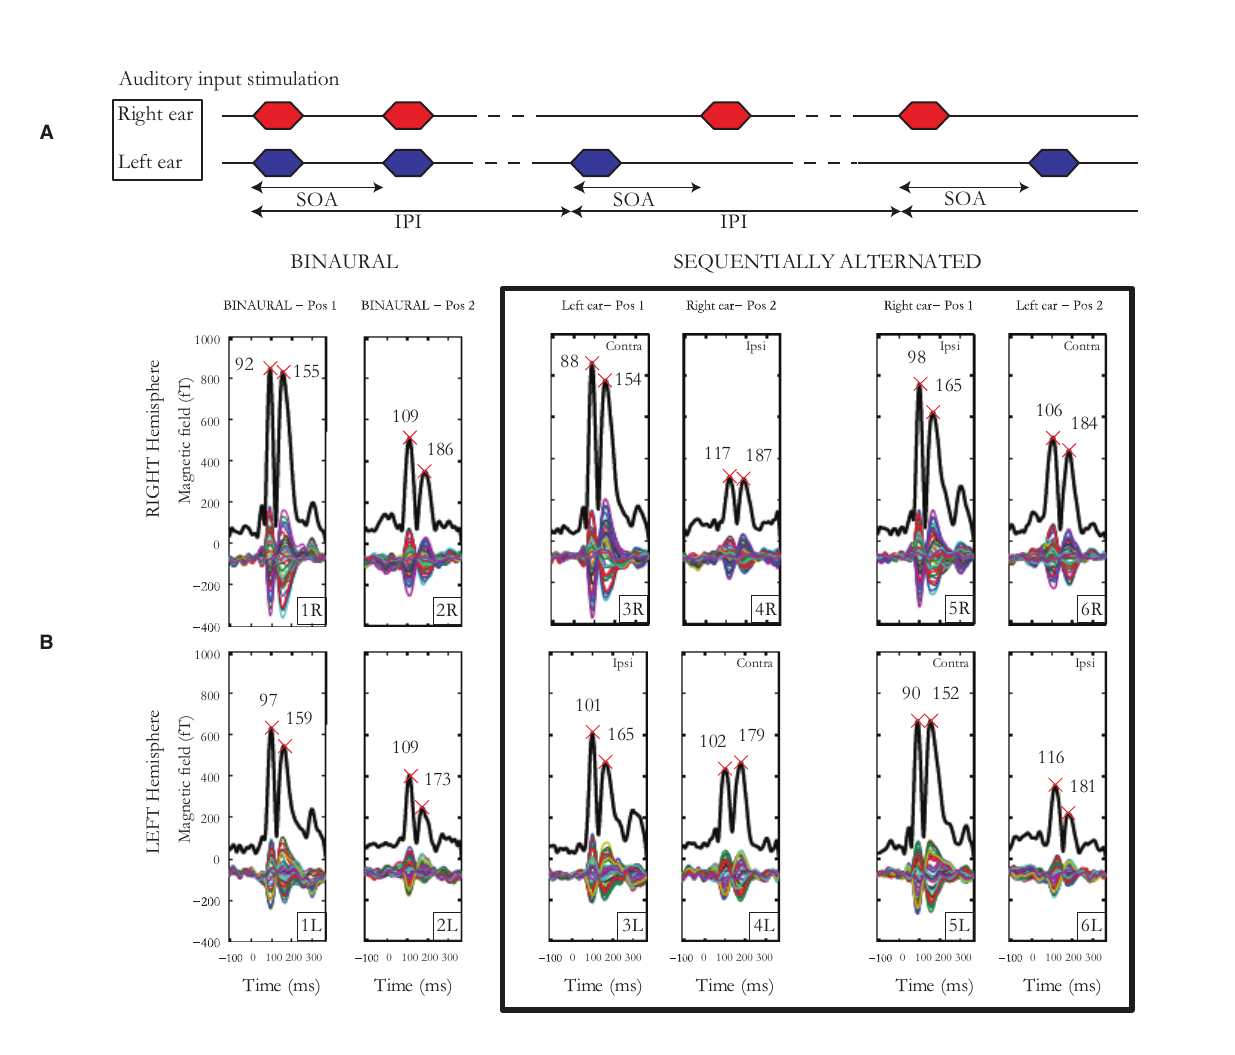
FIGURE 2 | (A) Auditory input stimulation representing the binaural condition to the left, the sequentially alternated conditions “left ear” followed by “right ear” in the middle and then the sequentially alternated “right ear” followed by “left ear” on the right. The stimulus onset asynchrony (SOA) represents the time between the start of the two stimuli of a pair, while the inter-pair interval (IPI) represents the time interval between the onset of two successive pairs of stimuli. (B) Cortical responses from subject 1 for SOAs jittered around 190ms. Multiple thin waveforms represent activity recorded by each of the 40 sensors located over the temporal lobe, in each hemisphere, after LS deconvolution, from − 100 to 380ms after stimulus onset. mGFP waveforms are represented with a thick black line, provided for both right and left hemispheres, the 3 presentation conditions (1 x binaural, 2 x sequentially alternated) and both first and second tone-bursts. Latencies of the N100m and P200m are indicated by